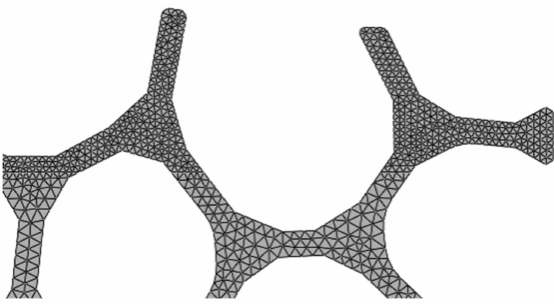
Figure 6. Detail of the finite element discretization for model A. A finer mesh was used in the upper region of the material, where larger strains were expected. Table 3. Chemical composition of the steel substrates according to EN10088-1.